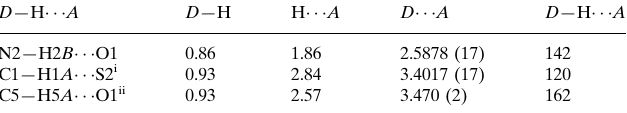
Hydrogen-bond geometry (A˚ , (cid:2)